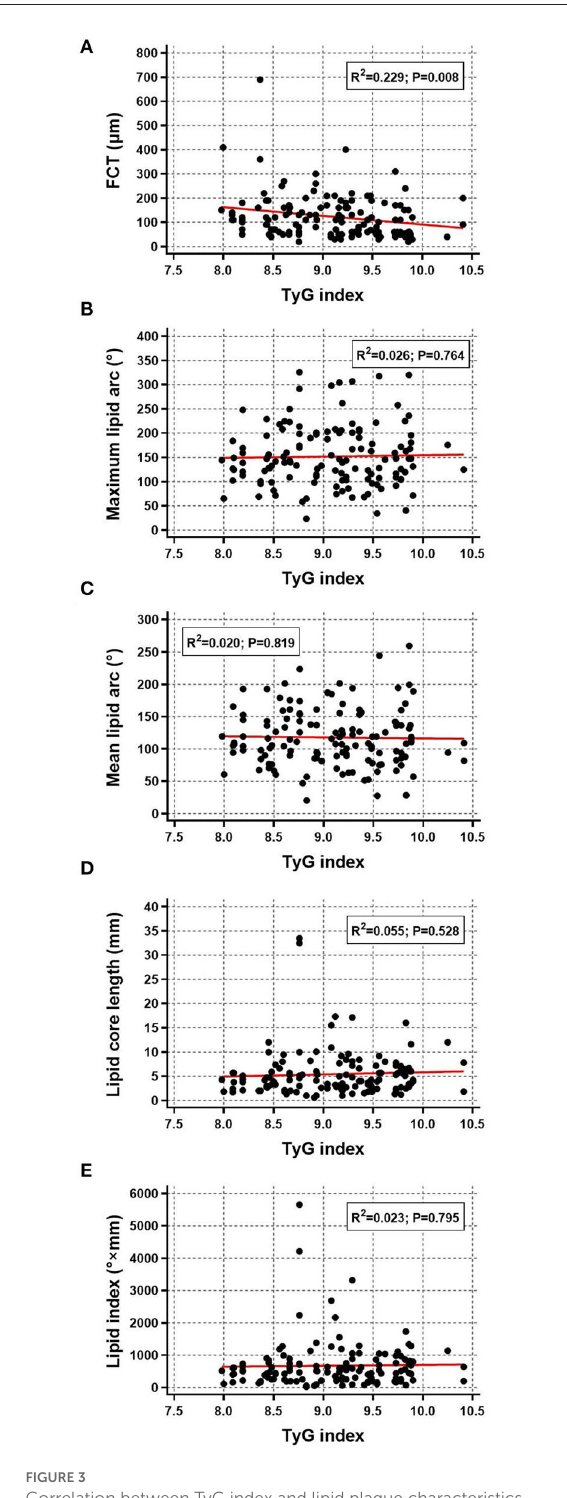
FIGURE3 Correlation between TyG index and lipid plaque characteristics. Scatter plot and linear regression analysis were performed for TyG index and lipid plaque characteristics including (A) FCT, (B) maximum lipid arc, (C) mean lipid arc, (D) lipid core length, and (E) lipid index. FCT, fibrous cap thickness; TyG,